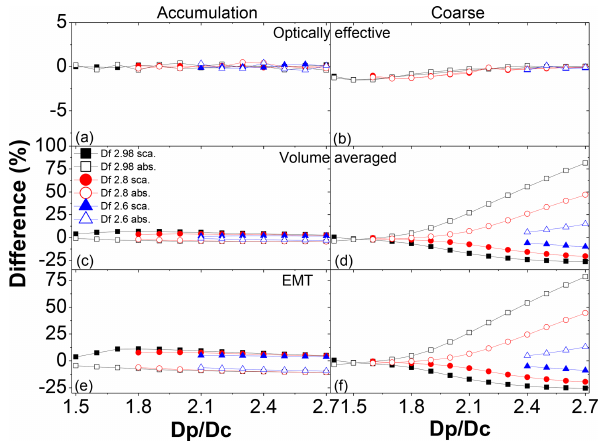
Figure 3. The relative differences of scattering and absorption cross sections of black carbon aggregates coated by sulfate induced by their optically effective complex refractive indices ( a and b ), and refractive indices based on the volume-weighted average method ( c and d ) and Bruggeman effective medium theory ( e and f ) as a function of shell / core ratio ( D p /D c ), in accumulation ( a , c and e ) and coarse ( b , d and f ) modes, respectively. Black squares, red cir- cles and blue triangles indicate BC fractal dimensions of 2.98, 2.8 and 2.6, respectively. Solid symbols denote scattering coefficients, while open interiors indicate absorption